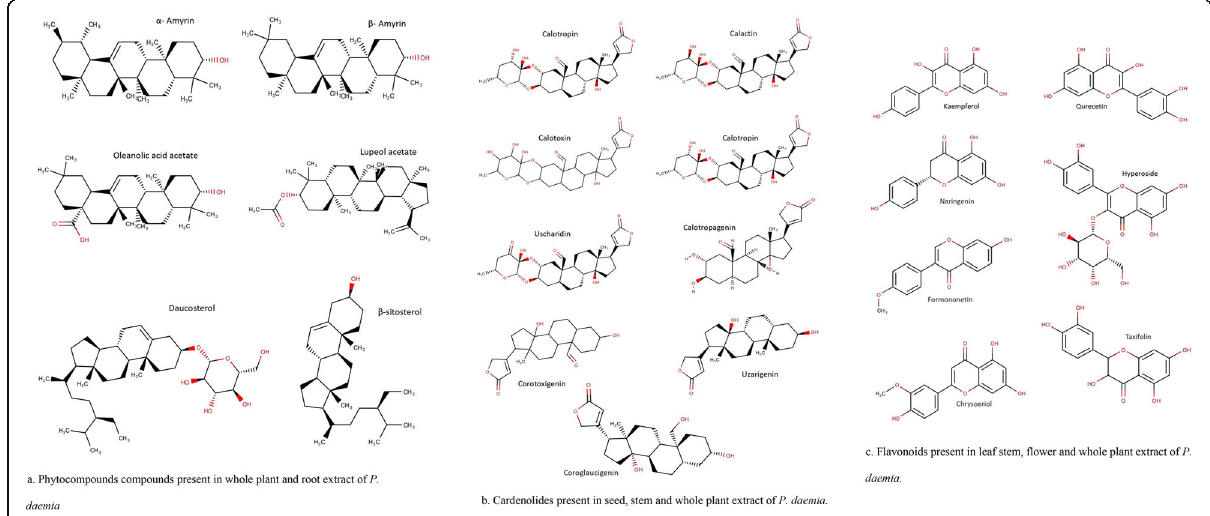
Fig. 3 Phytochemicals reported in P. daemia . a Phytocompounds compounds present in whole plant and root extract of P. daemia. b Cardenolides present in seed, stem and whole plant extract of P. daemia. c Flavonoids present in leaf stem, flower and whole plant extract of P.